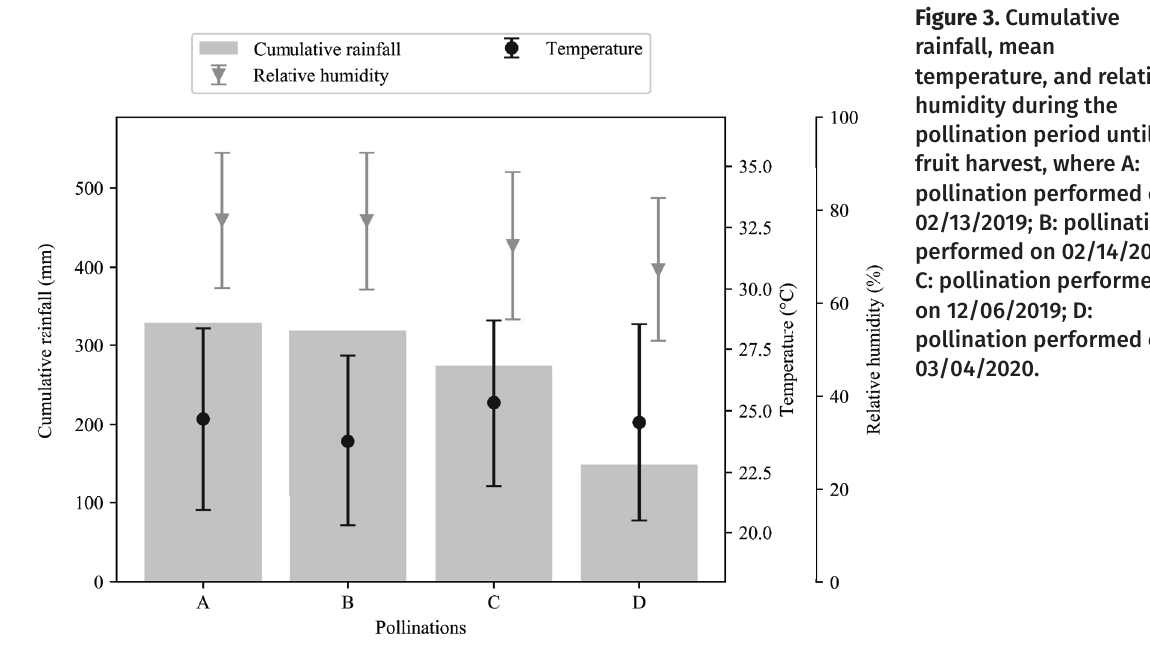
Figure 3. Cumulative rainfall, mean temperature, and relative humidity during the pollination period until fruit harvest, where A: pollination performed